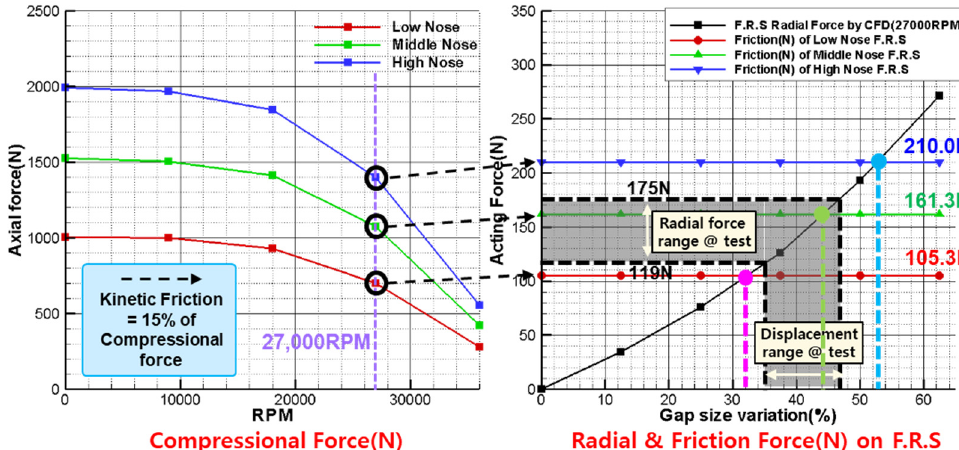
Figure 19. Forces acting on LOx floating ring with variations in nose position, rotating speed, and gap size.